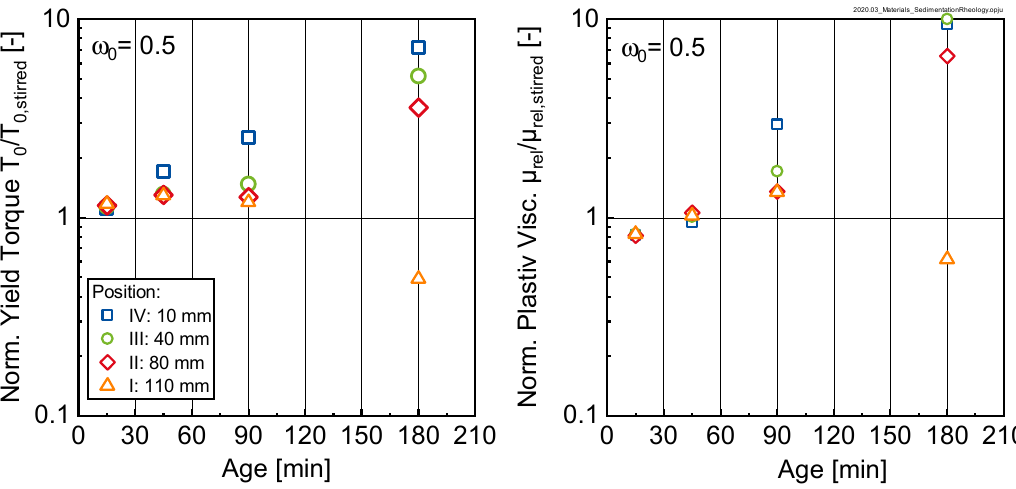
Figure 9. Yield torque (left) and relative plastic viscosity (right) of bleeding cement paste samples with an initial w / c-ratio ω 0 = 0.5 normalized by the corresponding values of identical pastes, which, however, were remixed (index ‘stirred’) prior to the measurement.